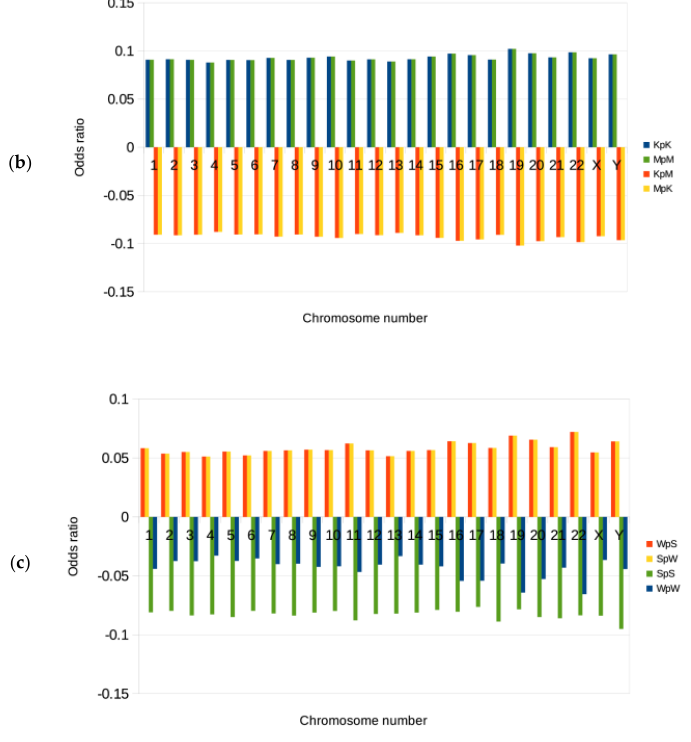
Figure 4. Dinucleotide odds ratios for the binary components. These charts show odds ratios for the four different dinucleotides in each of the RY, KM, and WS sequence datasets, across all the human chromosomes. The odds ratios shown are the mean values, scaled to zero for each of the chromosomes. A value of zero is synonymous with a randomized sequence or model. A value above zero for a given dinucleotide means that it is over-represented or enhanced in the dataset, and if it is less than zero, it is under-represented or suppressed. ( a ) RY binary component: In this sequence dataset, there are four possible dinucleotides, which are RpY, RpR, YpR, and YpY. The dinucleotides RpY/YpR are enhanced above the random expectation given the nucleotide content, and RpR/YpY are suppressed, or below the random expectation. This profile is consistent for all the 24 chromosomes. RpY/YpR dinucleotides are flexible, while RpR/YpY are rigid, and so, in general, flexibility is enhanced while rigidity is suppressed in human chromosomal DNA. ( b ) KM binary component: KpM/MpK are suppressed, while KpK/MpM are enhanced across all the chromosomes. This pattern directly affects hydrogen-bonding donor-acceptor sites on the major groove of the DNA. Here, either sequential donors or sequential acceptors are favored. It is likely that this pattern is generally more favorable for the binding of particles to the DNA. ( c ) WS binary component: WpW and SpS are suppressed, while WpS and SpW are enhanced across all the chromosomes. Genomic DNA in general favors and enhances dinucleotides with a heterogeneous hydrogen-bonding donor-acceptor pattern in the minor groove of the DNA, and also a heterogeneous number of hydrogen-bonds between the base pairs. In contrast, homogeneous patterns are suppressed. It may be that this heterogeneous pattern of hydrogen bonding between base pairs is favored as it increases the stability of local secondary helical structures.